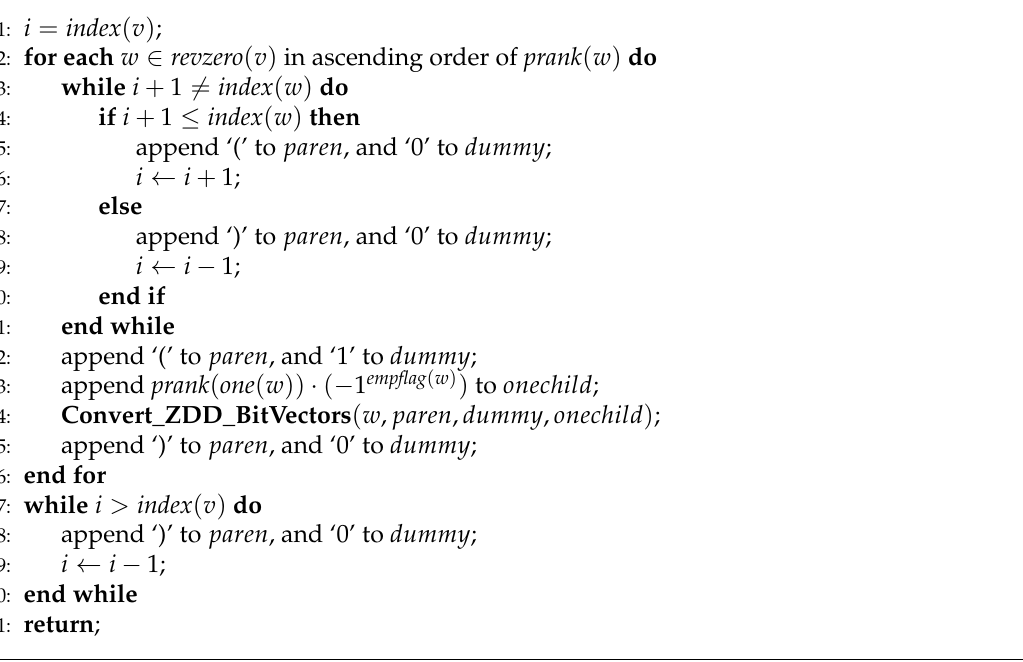
Algorithm 2 Convert_ZDD_BitVectors ( v , paren , dummy , onechild ): Algorithm for obtaining the BP representation of the zero-edge tree, the dummy node vector, and the one-child array.